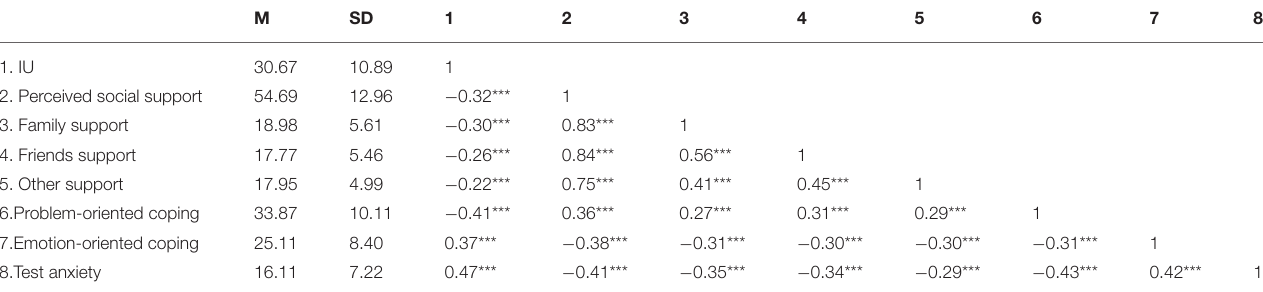
TABLE 2 | Mean, standard deviation, and Pearson correlation coefficient between the variables in each study ( n = 556).